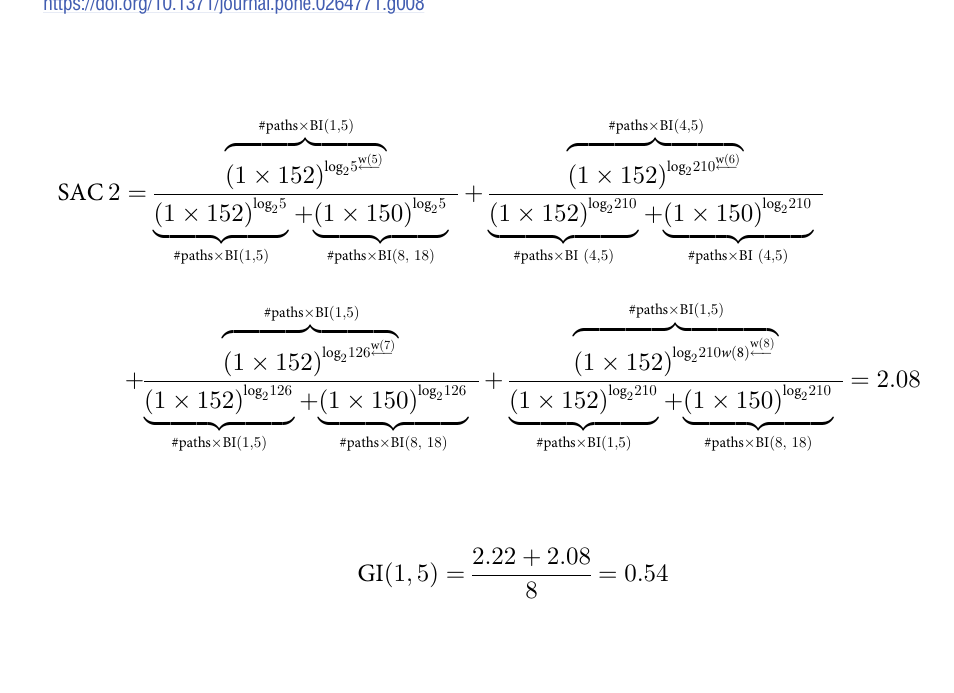
Fig 8. The GI and BI scores of all the Association Edges in our running MRG example after applying Eq 8 (recall Fig 6).